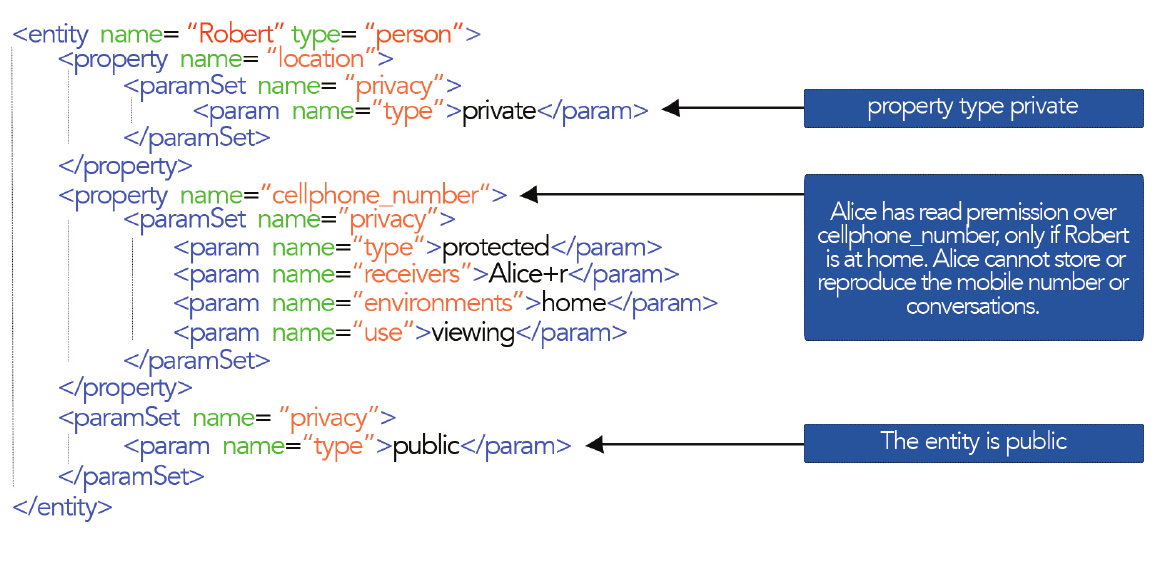
Figure 3. An entity with privacy